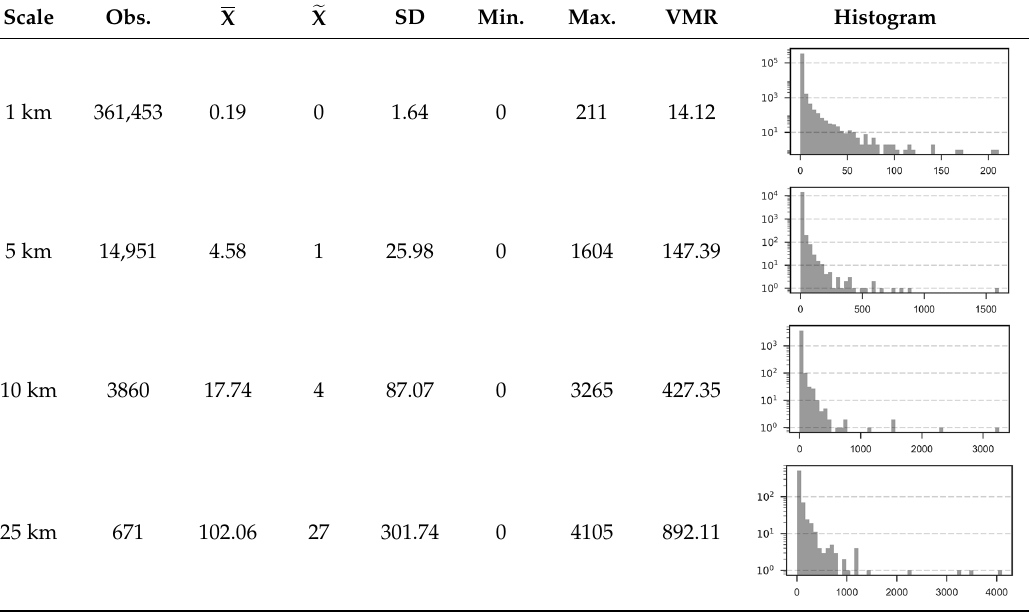
Table 1. Descriptive statistics of the aggregated software firm location pattern.